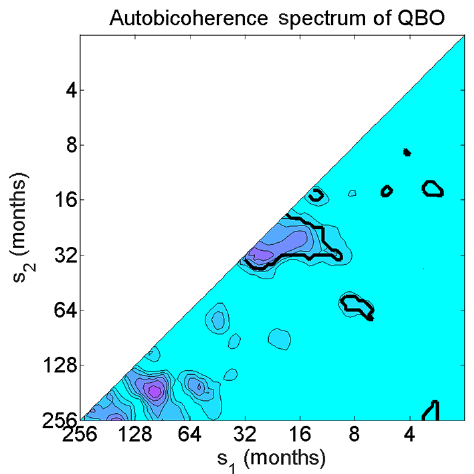
Figure 6. The wavelet-based autobicoherence spectrum of the QBO index for the period 1950–2013. Thick contours enclose regions of 5% pointwise